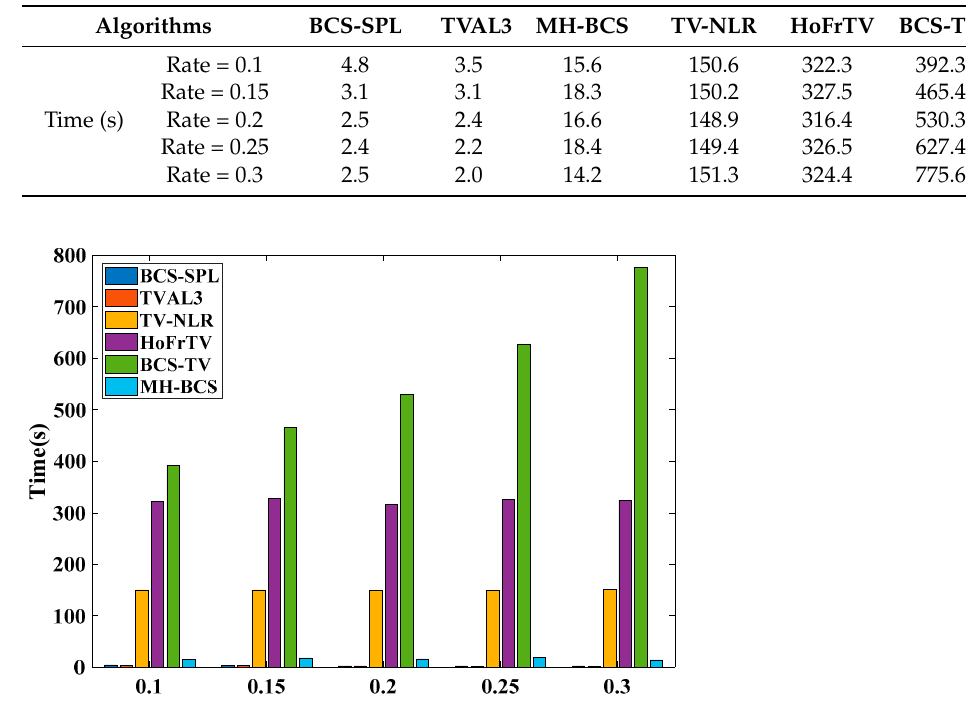
Table 7. Average reconstruction time(s).